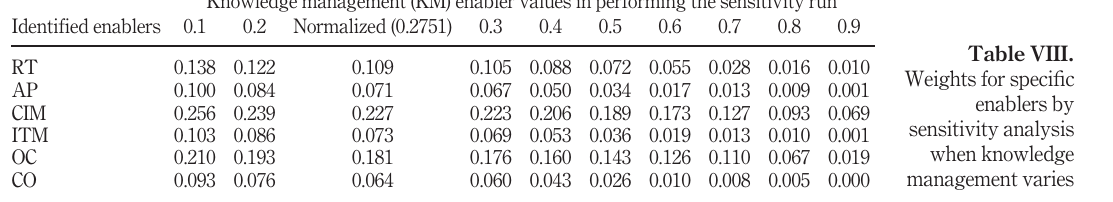
Table VIII. Weights for speci fi